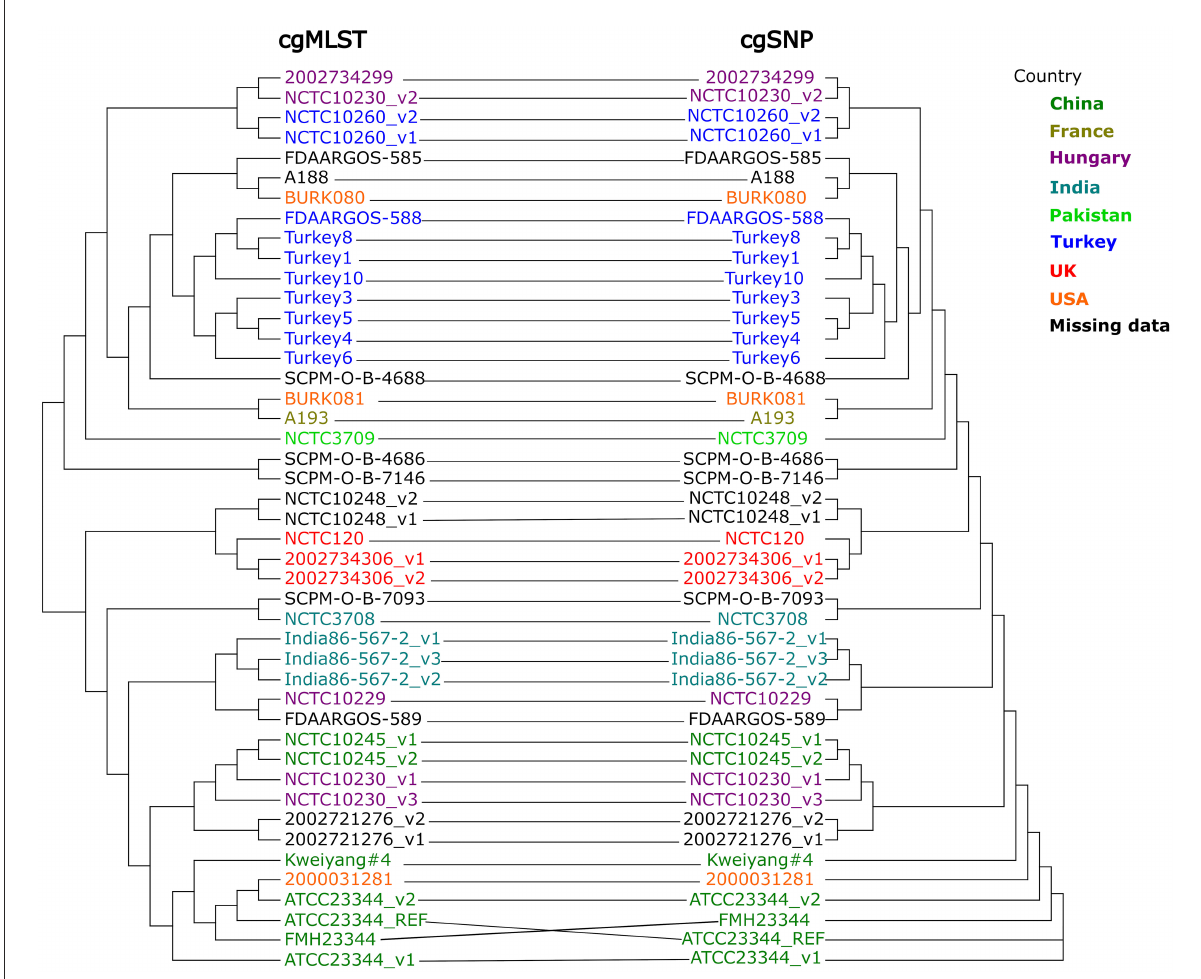
FIGURE5 Comparison of clustering generated by cgMLST and cgSNP analysis (59) (modified). Colors indicate country of origin of the strain as registered with the corresponding BioSample